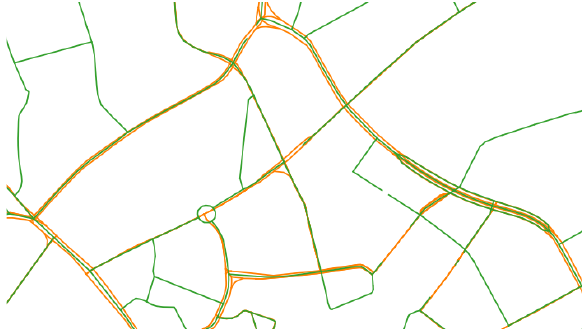
Figure 6. Geometrical differences of OSM (orange) and administration (green) street graph. In the snipped is shown the area of inner city ring road. The administration graph includes hierarchical smaller streets, but only one edge per